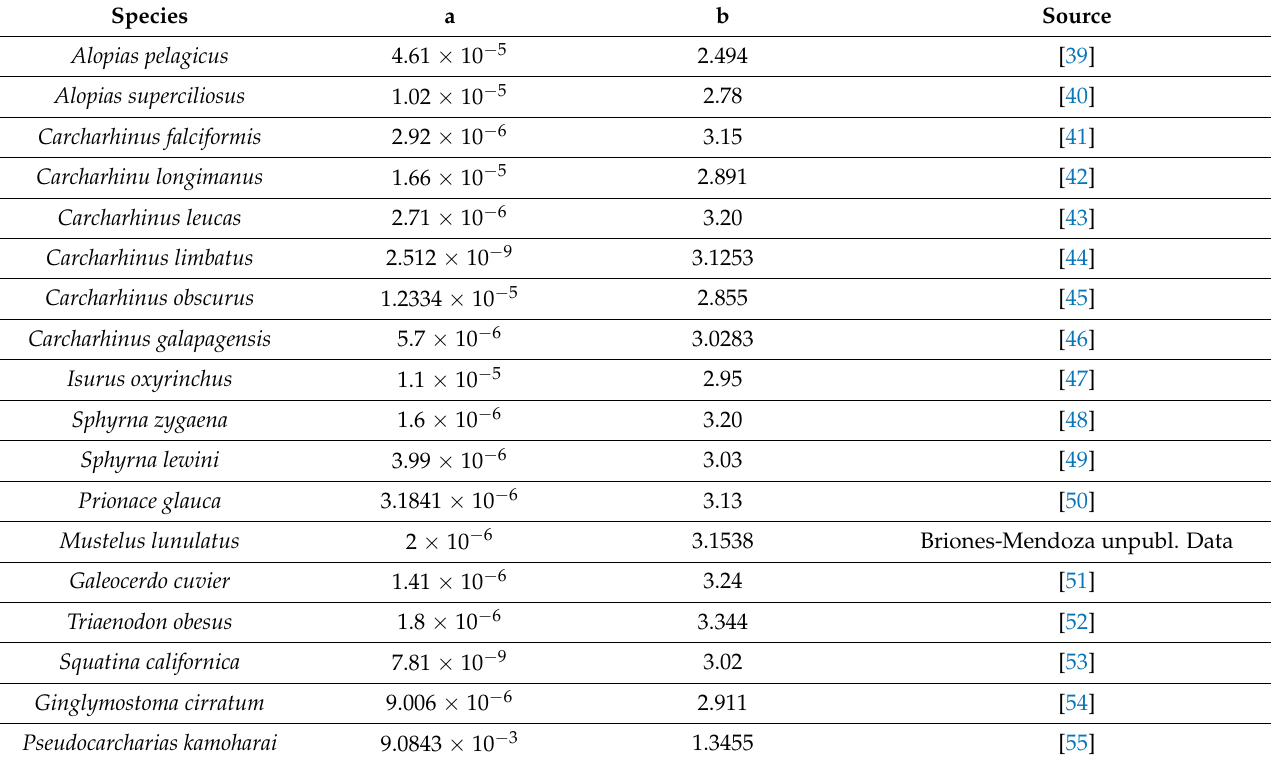
Table 1. Parameters used to estimate the weight from the length of the sharks landed in the Ecuado- rian